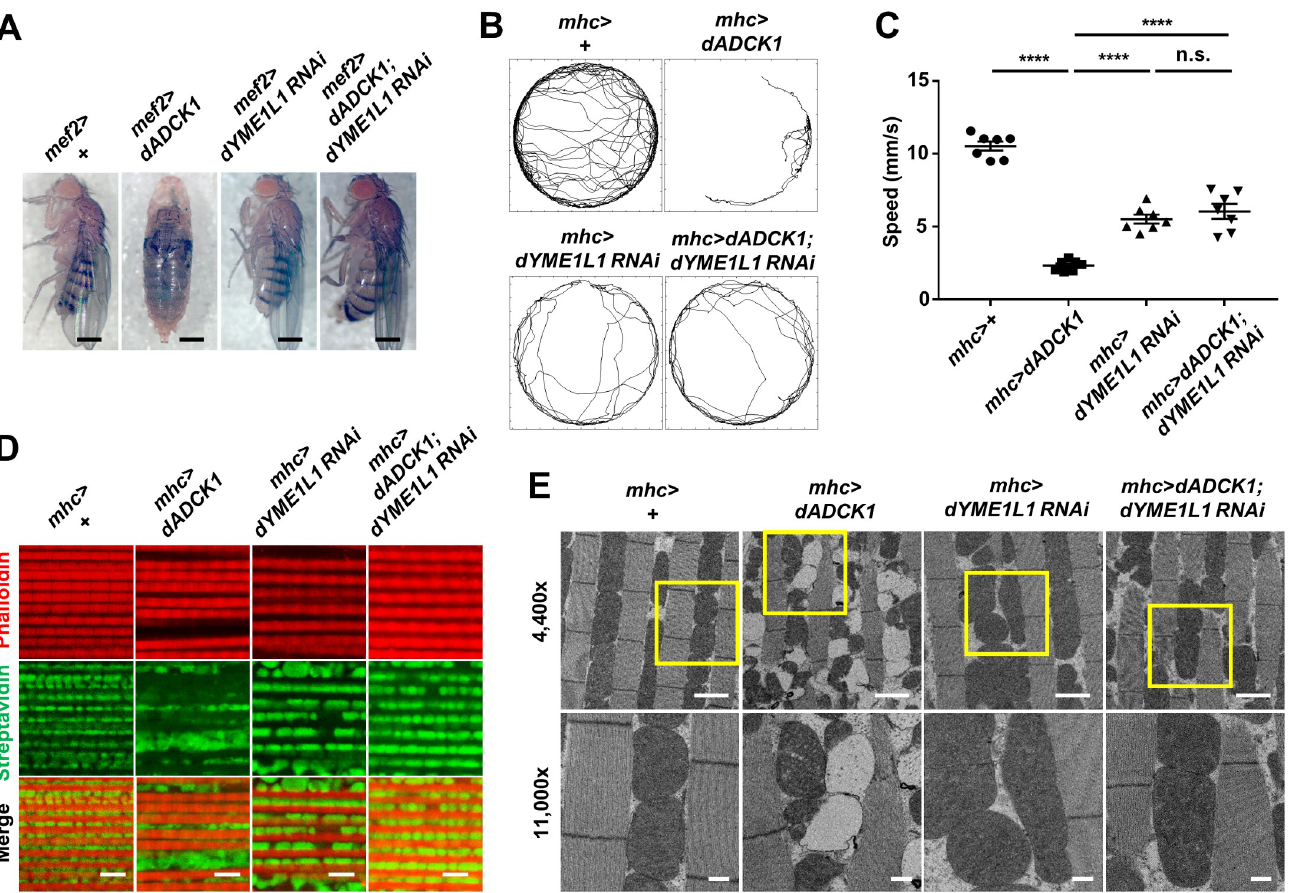
Fig 6. YME1L1 is a target of ADCK1. (A) Whole body images of the flies with indicated genotypes. Scale bars, 0.5 mm. (B) Movement trajectories of the adult flies with indicated genotypes. (C) Comparison of the means of walking speed for the flies with indicated genotypes, n = 7. ���� , p < 0.0001; n.s., not significant by unpaired t-test. (D) Fluorescent confocal microscopy images of the adult fly thoraces with indicated genotypes. Streptavidin (green) and phalloidin (red) staining used to mark mitochondria and muscle actin fibers, respectively. Scale bars, 5 μ m. (E) TEM images of adult fly thoraces with indicated genotypes. Scale bars, 2 μ m (4,400 × , top) and 500 nm (11,000 × , bottom). The boxed areas were enlarged in the bottom panels.